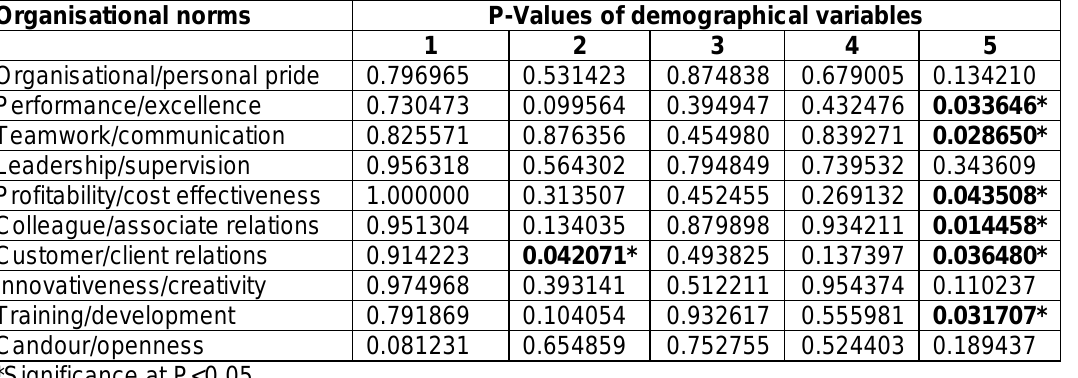
T-test statistics for establishing relationships between norms of and demographical differences of